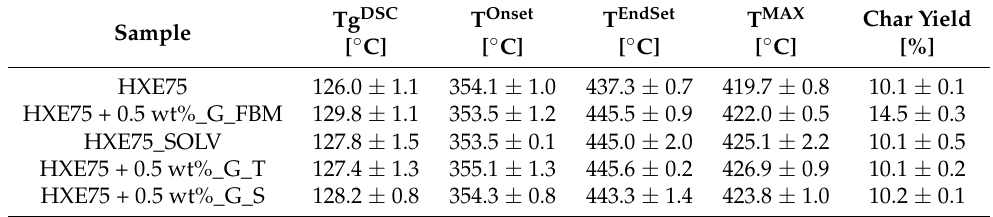
Table 2. Results of the thermal characterization (DSC and TGA) of the GNP based nanocomposites. Sample